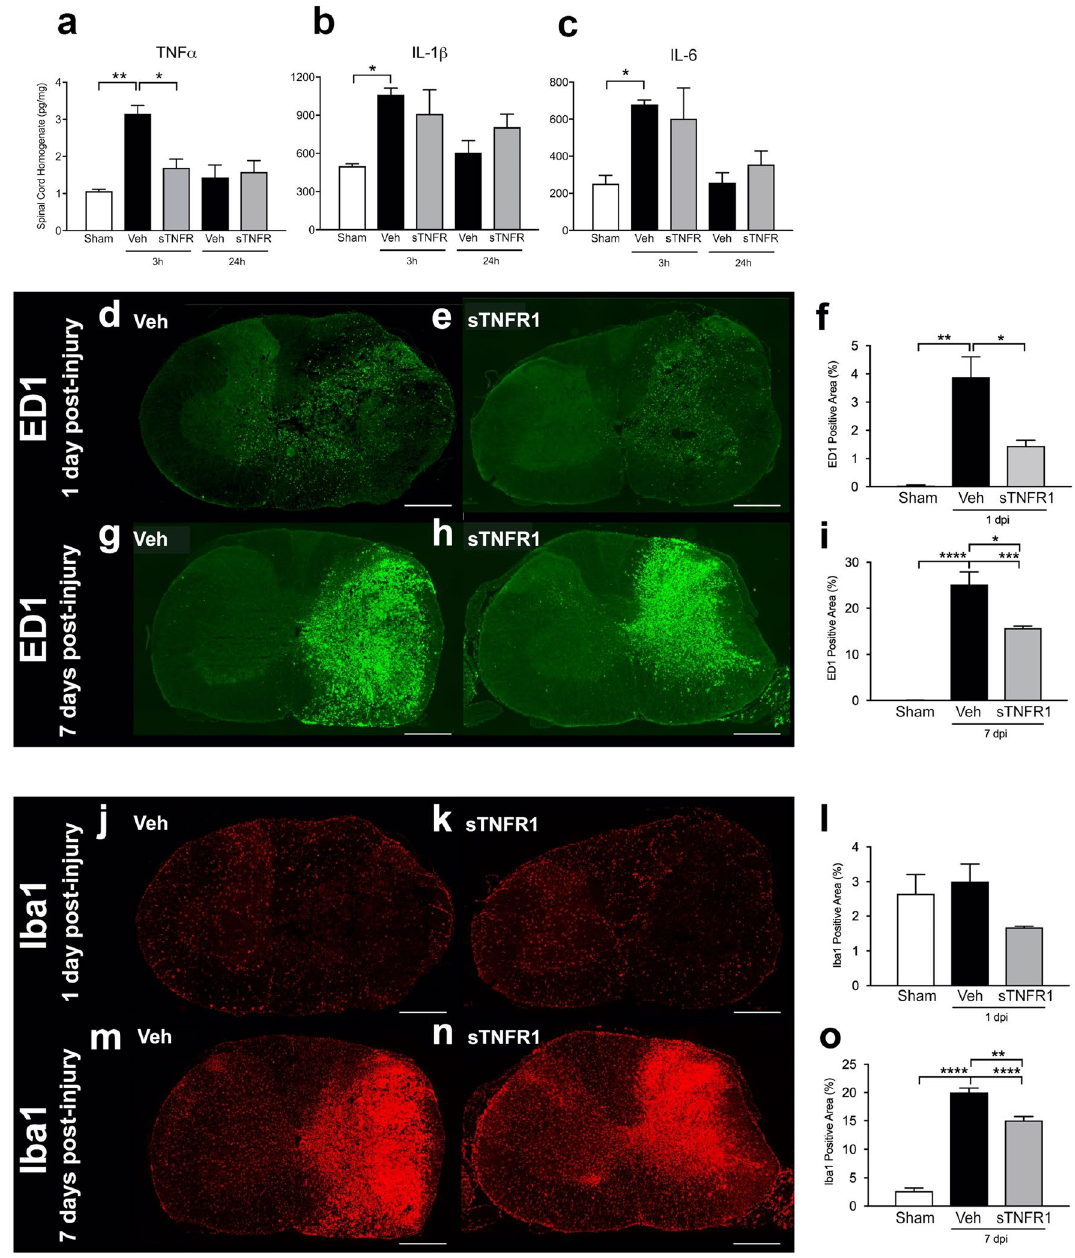
Figure 2. Acute sTNFR1 treatment reduces indicators of neuroinflammation. ( a – c ) Spinal cord injury produces a strong early (3 h) inflammatory cytokine ( a, TNFα, b, IL1-β, and c, Il-6) protein expression. TNFα expression is significantly mitigated by sTNFR1 treatment. Immunohistochemical stain of injured spinal cord shows SCI- induced expression of ED1 + cells (microglia/macrophage) at 1 day ( d ) and 7 days ( g ) post-injury, and early i.t. sTNFR1 treatment significantly reduces ED1 at both 1 day ( e , f ) and 7 days (h , i ) . Expression of Iba1 + cells following spinal cord injury at 1 day ( j ) and 7 days ( m ) post-injury. Early i.t. sTNFR1 treatment did not affect Iba1 + (microglia) expression at 1 day ( k , l) post-injury, but did significantly reduce Iba1 expression by 7 days post-injury ( n , o ). Scale bars represent 400 um. Error bars represent standard error of the mean, n = 4 rats per group, One-way ANOVA, *p < 0.05, **p < 0.01, ***p < 0.001, ****p <